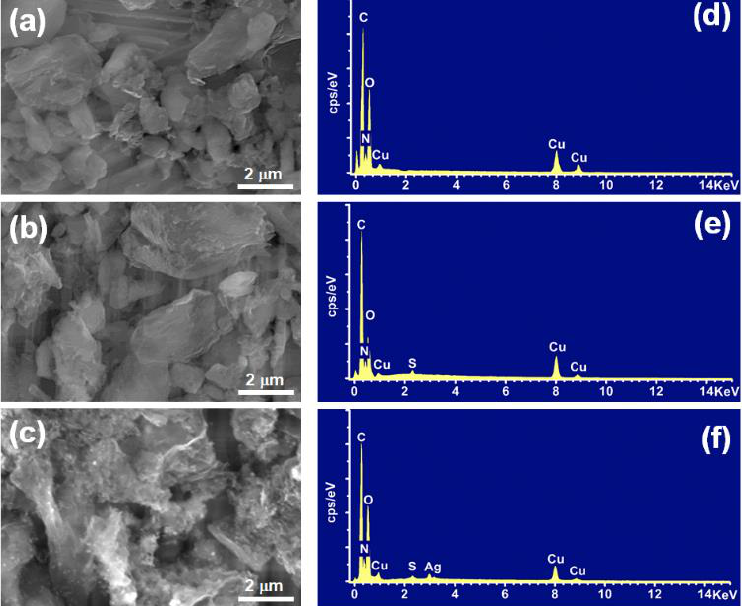
Figure 7. ( a – c ) SEM analysis and ( d – f ) EDS analysis of rGO 2 %@ g -C 3 N 4 , HS-rGO 2 %@ g -C 3 N 4 , and AgNPs-S-rGO 2 %@ g -C 3 N 4 .